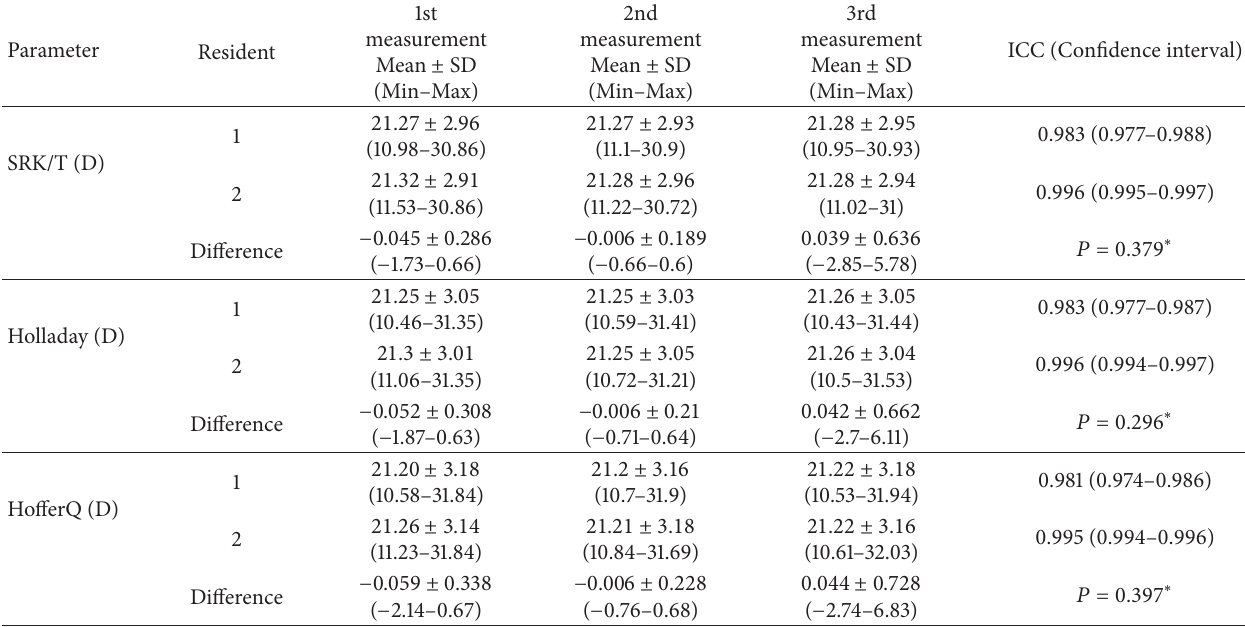
Table 2: Comparison of three consecutive IOL power measurements taken by both ophthalmology residents (Repeatability).